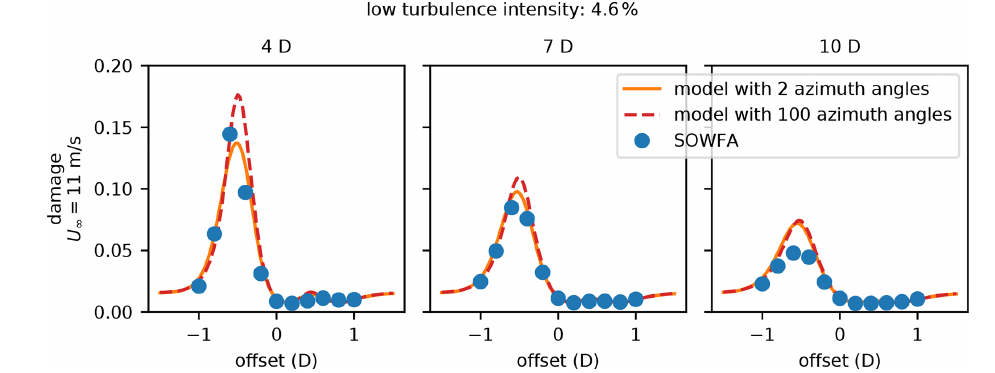
Figure 9. Final damage plots calculated with different numbers of azimuth angle evaluations. The orange line represents damage calculated with 2 azimuth angle evaluations at 90 and 270 ◦ , the dashed red line represents the damage calculated with 100 azimuth angle evaluations, and the blue points show the damage calculated with the high-fidelity SOWFA